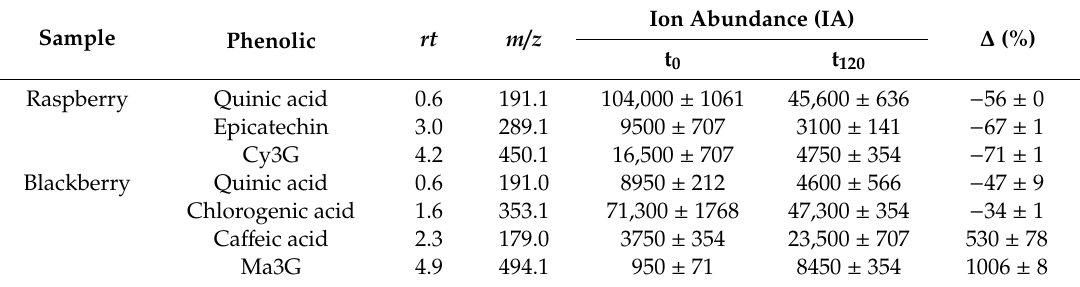
Table 3. First-pass metabolism of phenolic compounds from selected berries: HPLC-ESI-q-TOF-MS 1,2 .